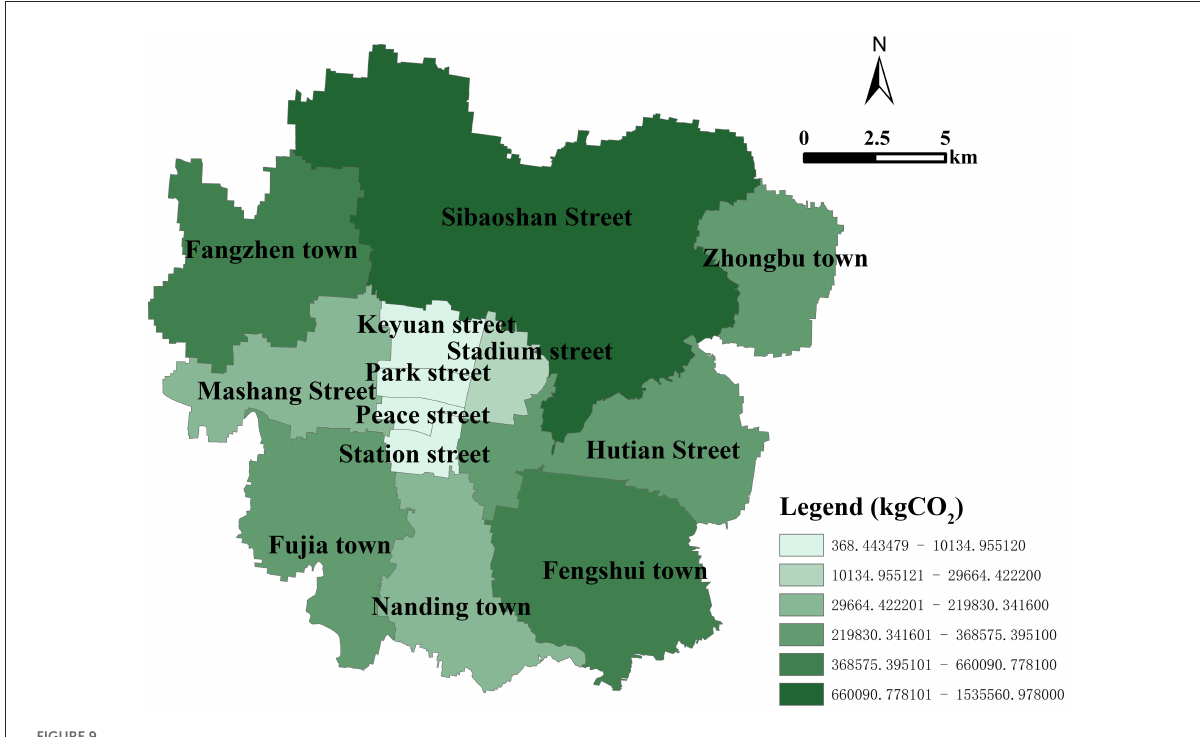
FIGURE9 Carbon absorption of subdistricts in